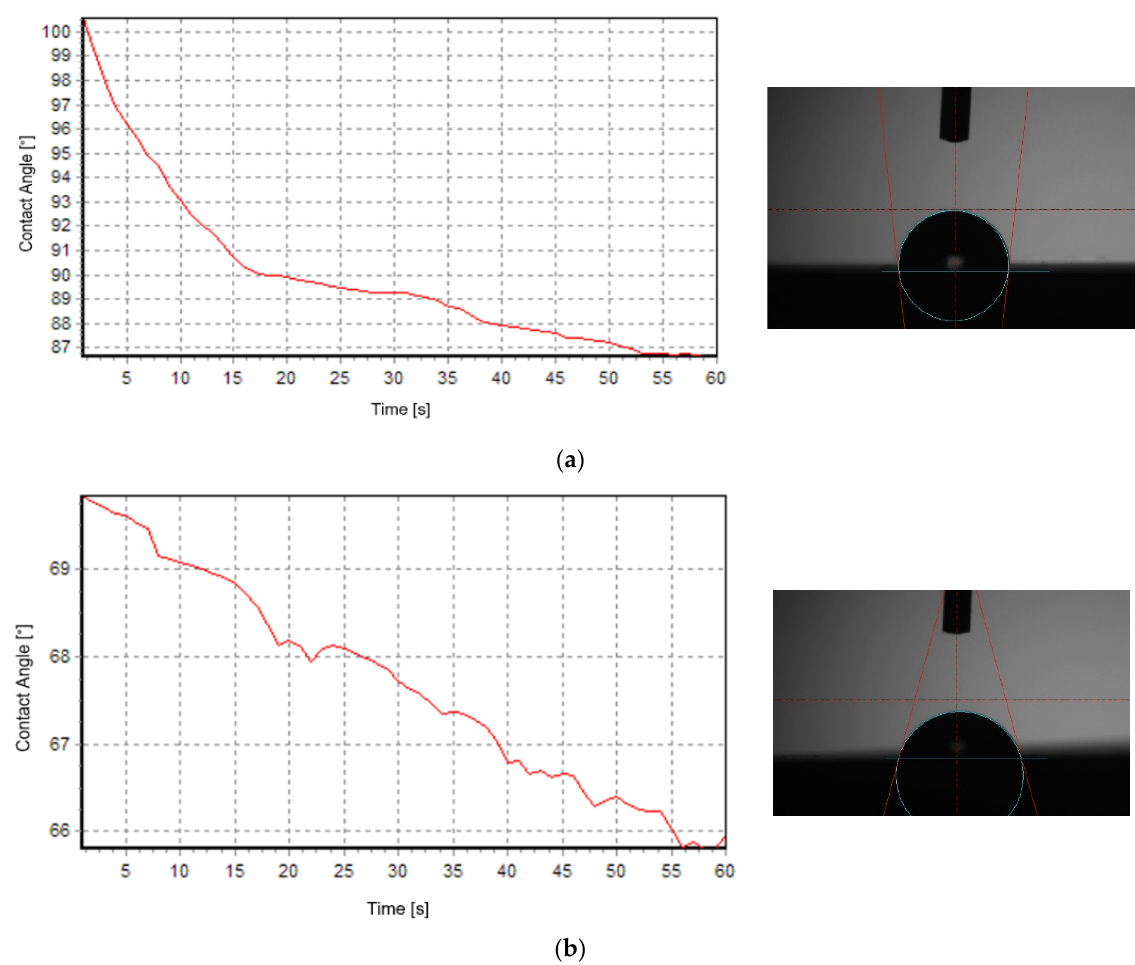
Figure 2. Contact angle measurements: ( a ) distilled water as the measure liquid; ( b ) diiodomethane as the measure liquid. Table 3. SFE and WCA results.